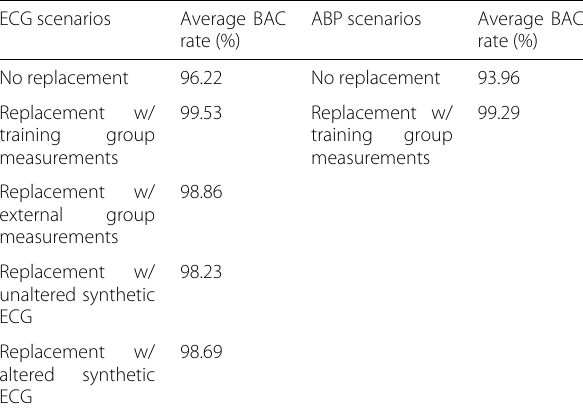
Table 2 Summary of security analysis